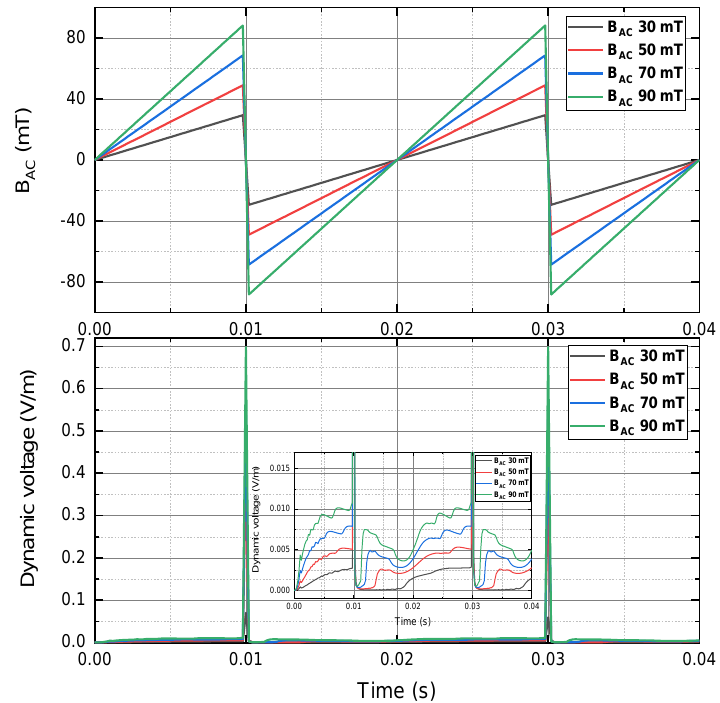
Figure 8. Instantaneous dynamic voltage of a 4 mm HTS tape, carrying a 30 A DC transport current and in the presence of the perpendicular sawtooth AC magnetic field at 50 Hz, with the peak magnitude 30 mT, 50 mT, 70 mT and 90 mT.